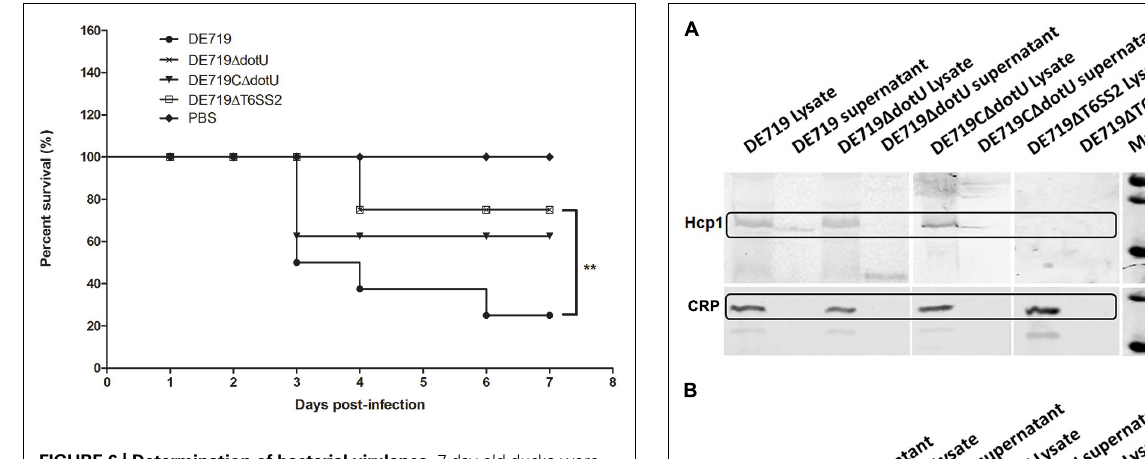
DELETION OF DotU AND T6SS2 ATTENUATES APEC STRAIN DE719 VIRULENCE IN